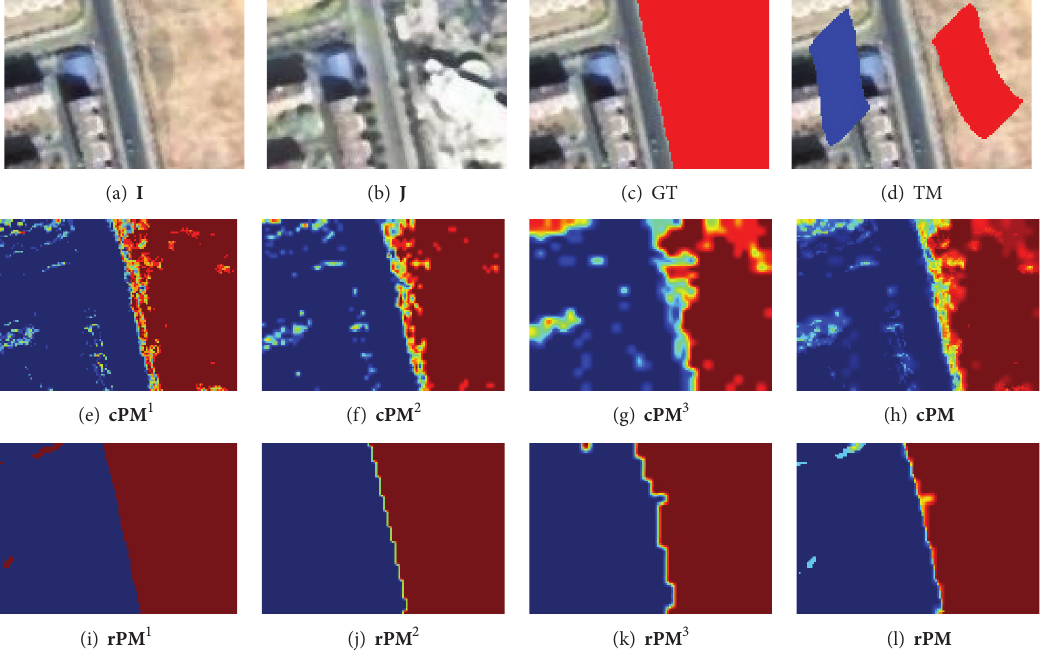
Figure 2: A toy example for estimating the probability maps. (a)–(d) Image I , image J , ground truth (GT) image that is superposed on I with red, and training mask (TM) image with red and blue denote the labeled changed and unchanged pixels, respectively. (e)–(g) The estimated coarse probability maps cPM 𝑠 ( 𝑠 = 1, 2, 3 ) by KNN and (h) the weighted sum of them, cPM . (i)–(k) The refined probability maps rPM 𝑠 ( 𝑠 = 1,2, 3 ) and (l) the weighted sum of them, rPM